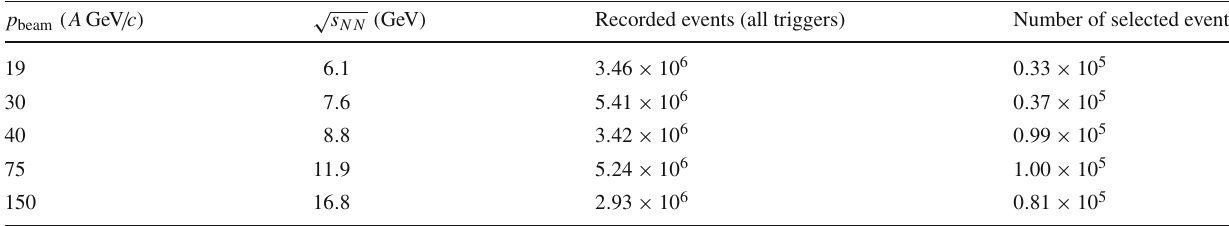
Table 1 Basic beam properties, number of events recorded, and number of events selected for the analysis for 7 Be + 9 Be interactions of 5 % most central collisions at incident momenta of 19 A , 30 A , 40 A , 75 A and 150 A GeV / c √ p beam ( A GeV / c ) s NN ( GeV ) Recorded events (all triggers) Number of selected events 6 . 1 3 . 46 × 10 6 0 . 33 × 10